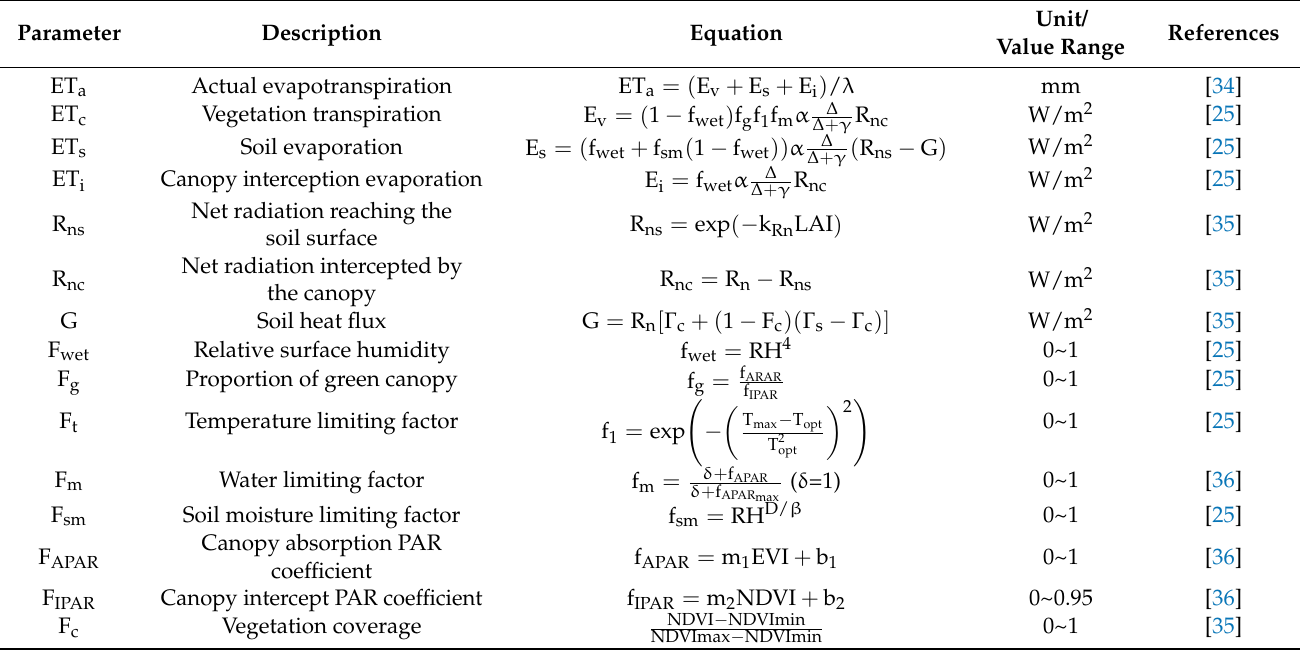
Table 1. Model equations and